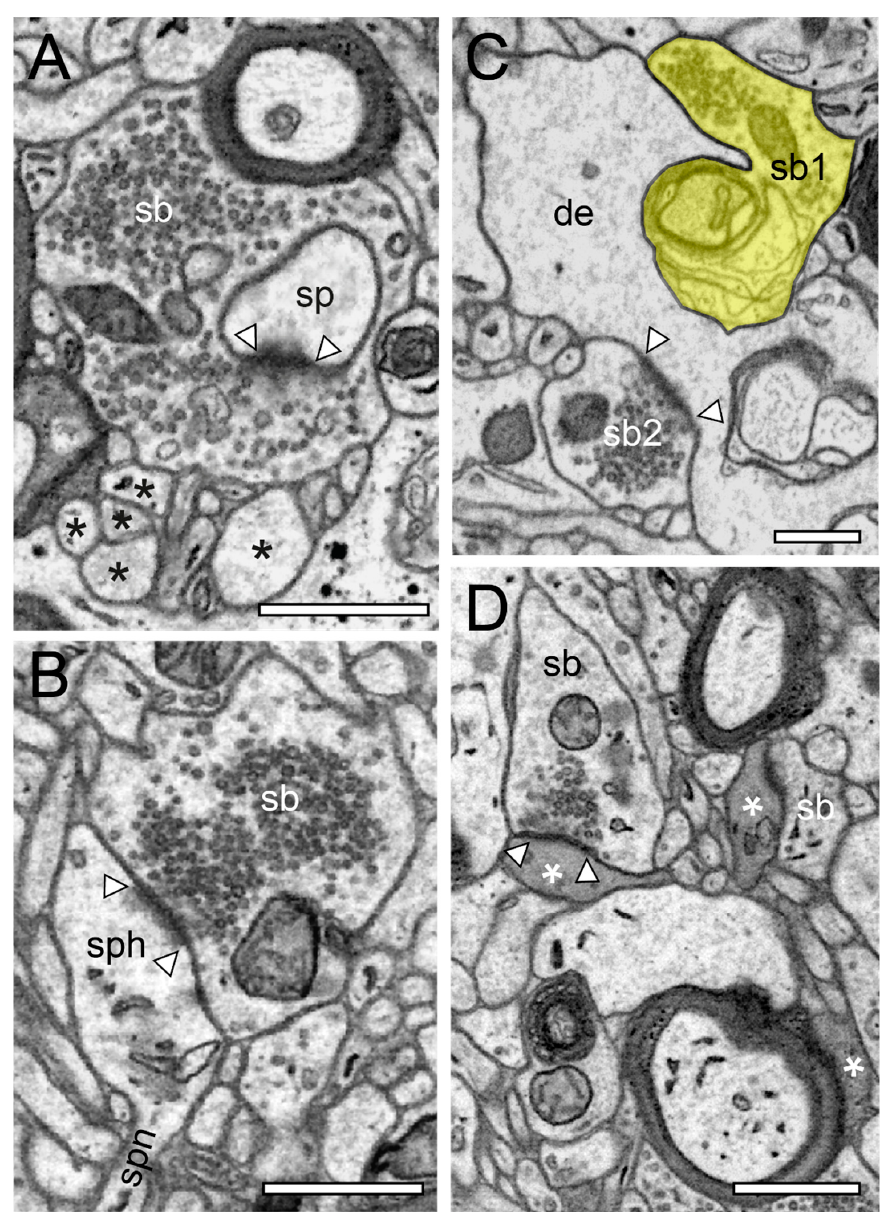
Figure 3. Structural characteristics of SBs in the human TLN as revealed by FIB-SEM. ( A ), Large SB (sb) invaginating a dendritic spine (sp) in L5 of the gyrus temporalis medialis. The AZ is marked by arrowheads. Note the cluster of unmyelinated axons (asterisks) close to the end terminal bouton. ( B ), Large synaptic bouton (sb) terminating on a large spine head (sph) of a short-necked spine (spn) in L6 of the gyrus temporalis. ( C ), Dendrite (de) with two SBs (sb1, sb2); sb1 with a large tangled structure (highlighted in transparent yellow) within the interior of the bouton invaginating the dendrite, whereas sp2 shows a “normal” appearance. The AZ in sb2 is marked by arrowheads. ( D ), Small caliber astrocytic processes (asterisks) identifiable by their darker appearance in the surrounding neuropil in L6 of the gyrus temporalis inferior. Infrequently, these astrocytic processes receive synaptic input by an SB (sb) identifiable by the establishment of a prominent AZ (arrowheads). Scale bar in ( A – D ), 0.5 µm showed layer-specific differences. It has been shown recently that the size of the readily releasable (RRP) dynamically regulates multivesicular release in mice [30], which also seemed to be the case at SBs in the human TLN.